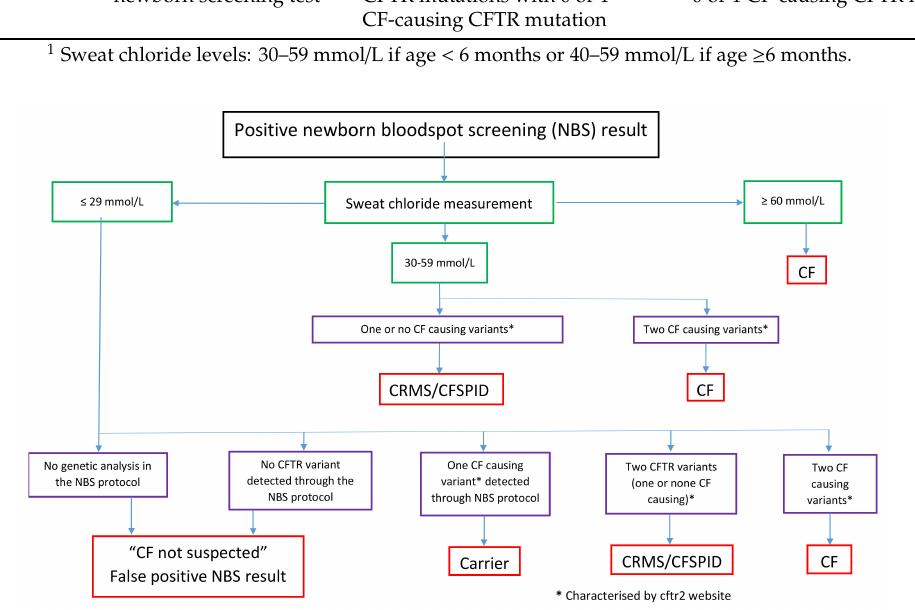
Figure 1. An algorithm for the designation of infants, following the positive newborn screening (NBS) result [9]. CF: Cystic fibrosis, CFTR: CF transmembrane conductance regulator (gene), CFMS: CFTR-related metabolic syndrome, CFSPID: CF screen-positive, inconclusive